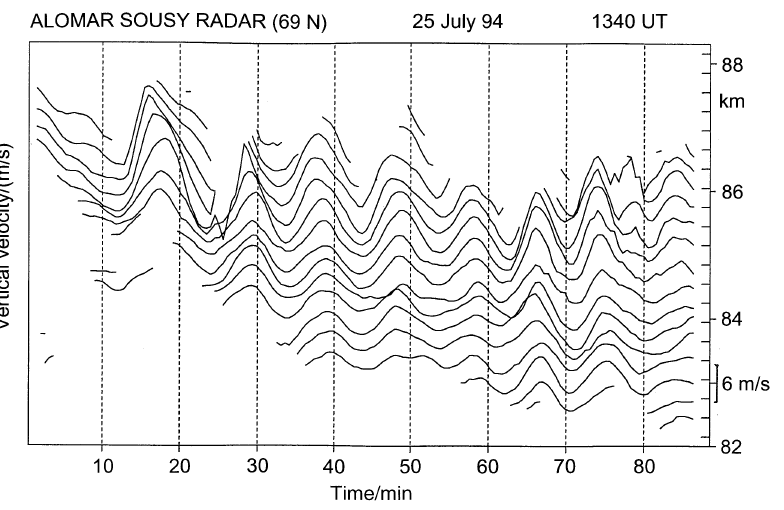
Fig. 1. Height-time intensity plots of the signal-to-noise ratio ( upper part ) and the radial velo- city ( lower part ) measured in the vertically pointing beam